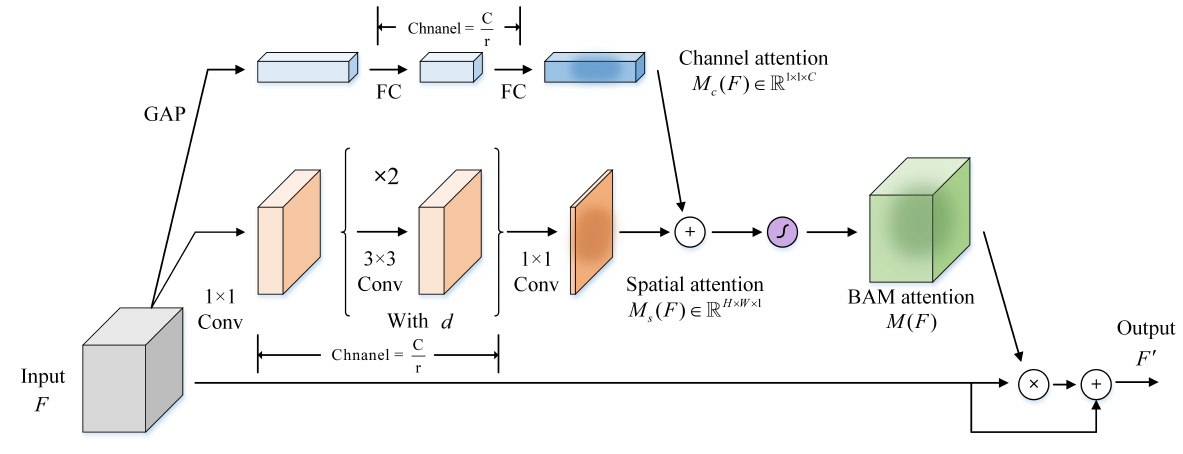
Figure 24. BAM module architecture. Two hyper-parameters d , r for this module, ref. [138] set d = 4, r =